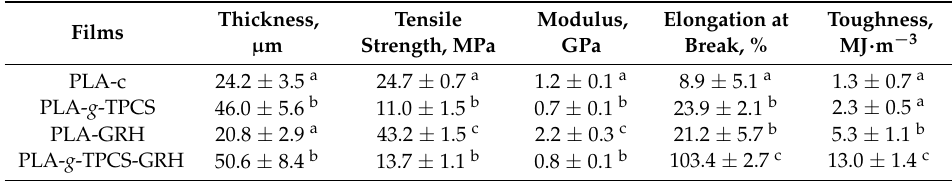
Table 5. Tensile properties of films produced by cast-film extrusion.